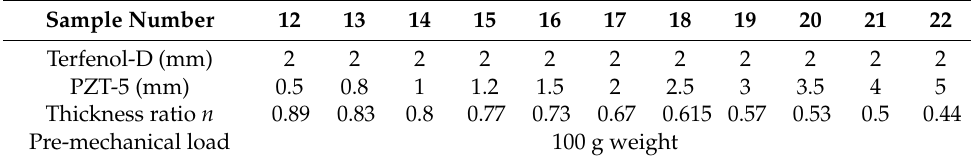
Table 3. The configuration of ME laminate sample under 100 g weight mechanical